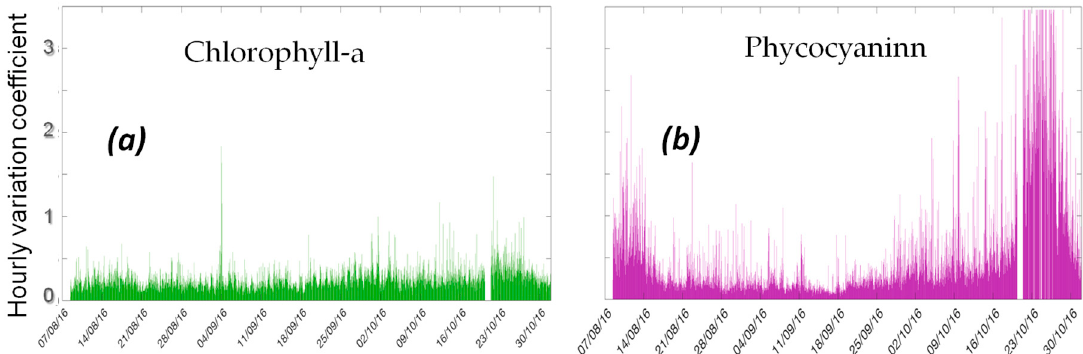
Figure 7. Hourly variation coefficients of ( a ) Chlorophyll-a measurements, and ( b ) Phycocyanin measurements.